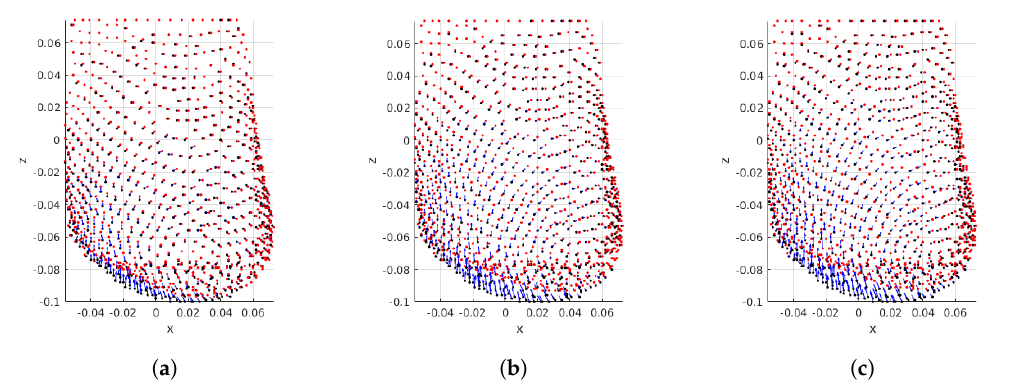
Figure 12. Influence of tumor size: PCLs are shown for the same patient with BI-RADS A, and tumor on region UOQ. Pre- and post-surgical data on black and red, respectively. Blue arrows indicate displacement direction and magnitude. ( a ) Small; ( b ) Medium; ( c )